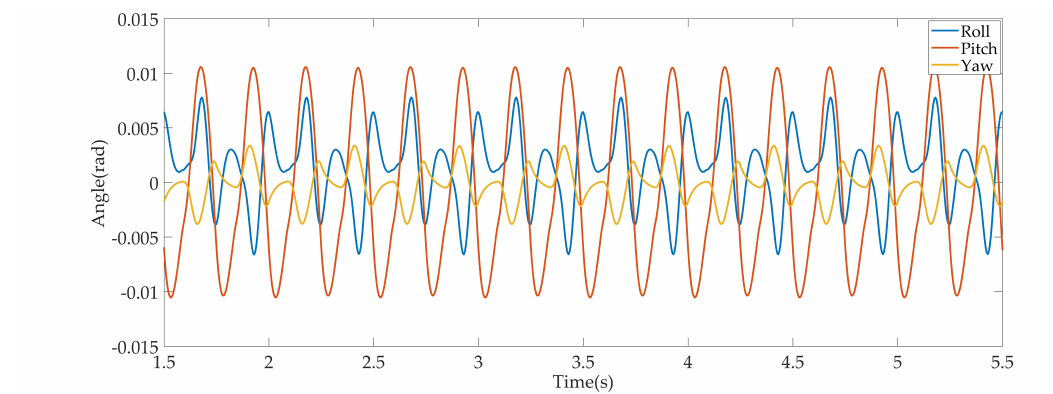
Figure 8. The attitude of the robot in the